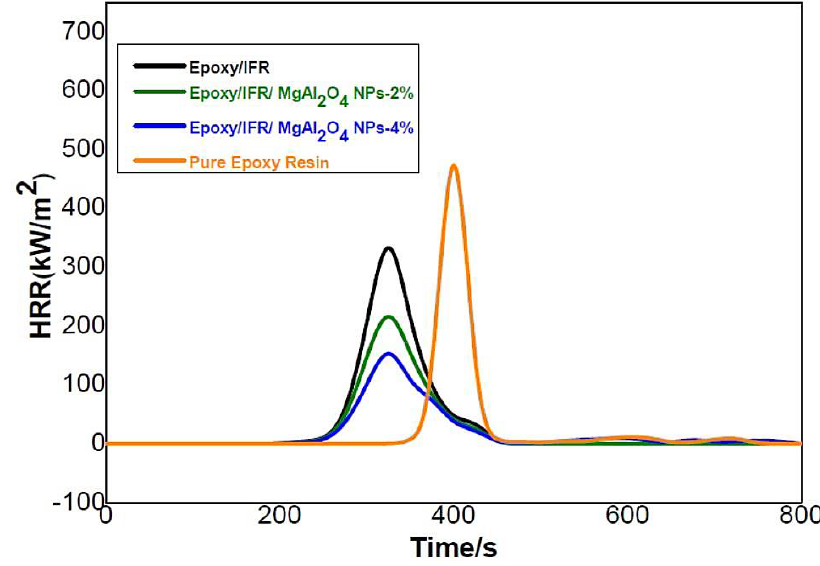
Figure 12. PHRR curves of coatings.